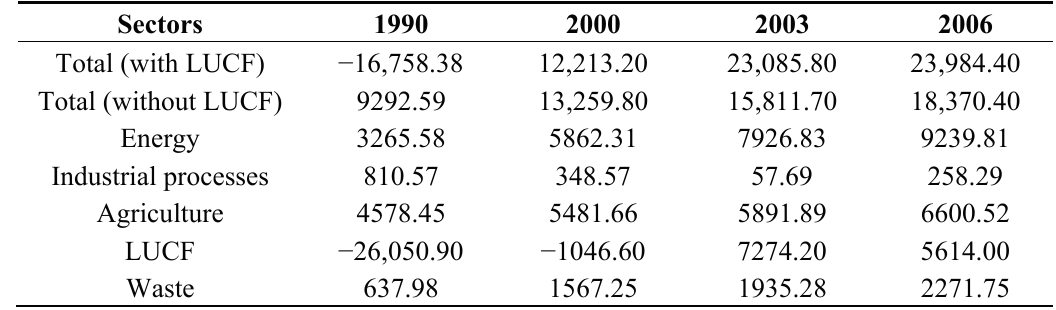
Table A2. Total Emissions/removals by sectors for the period 1990–2006 (GgCO 2 e). Source: Authors’ compilation from EPA [1].